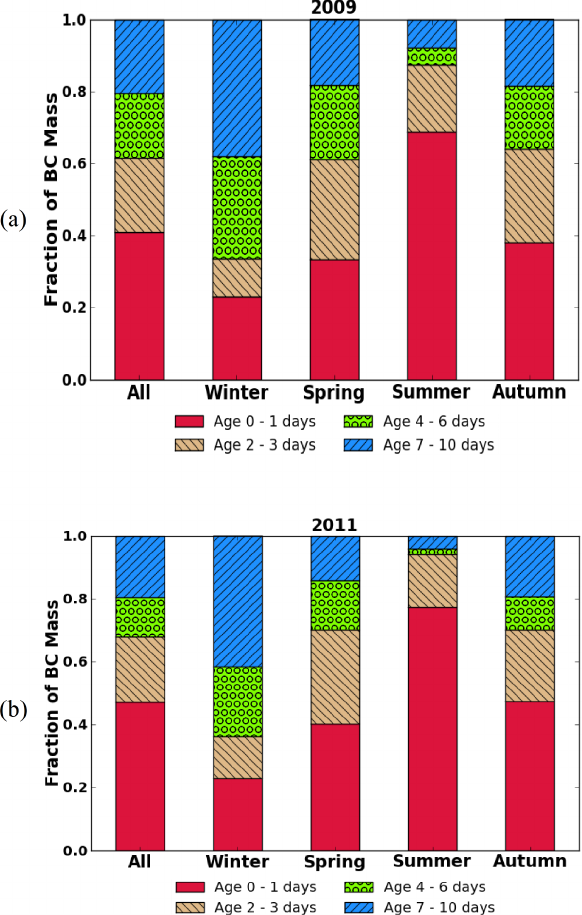
Figure 8. Fraction of simulated BC mass at Gadanki with particles of different age for year (a) 2009 and (b) 2011. Age 0–1 days repre- sents contribution from day 1 for the backward simulation. Age 2–3 days represents day 2 and day 3 contribution, Age 4–6 days repre- sents day 4 to day 6 and Age 7–10 represents day 7 to day 10. Note that 2009 simulations are without wet deposition whereas 2011 sim- ulations are with wet